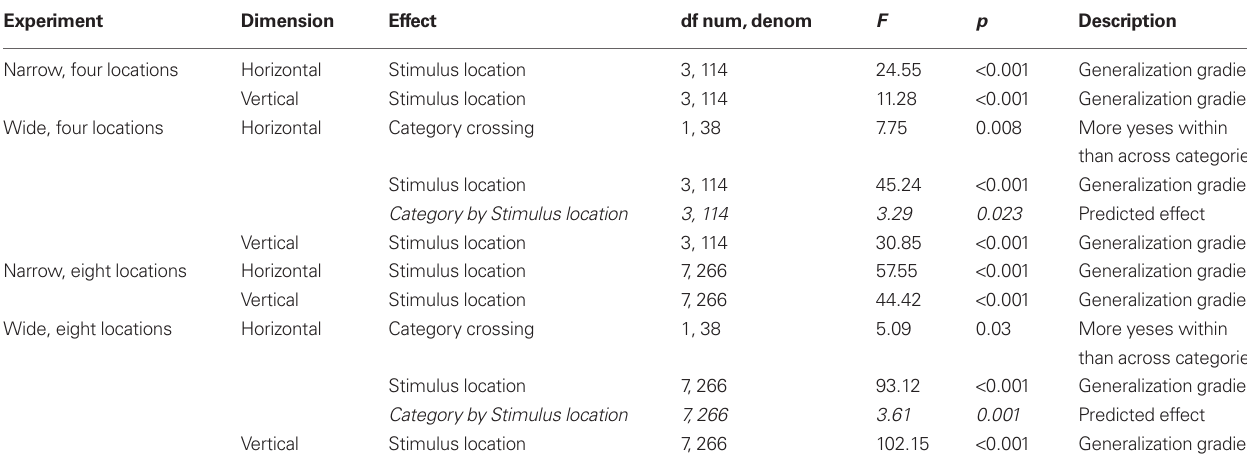
Table 1 | Statistical effects for proportion of “yes”